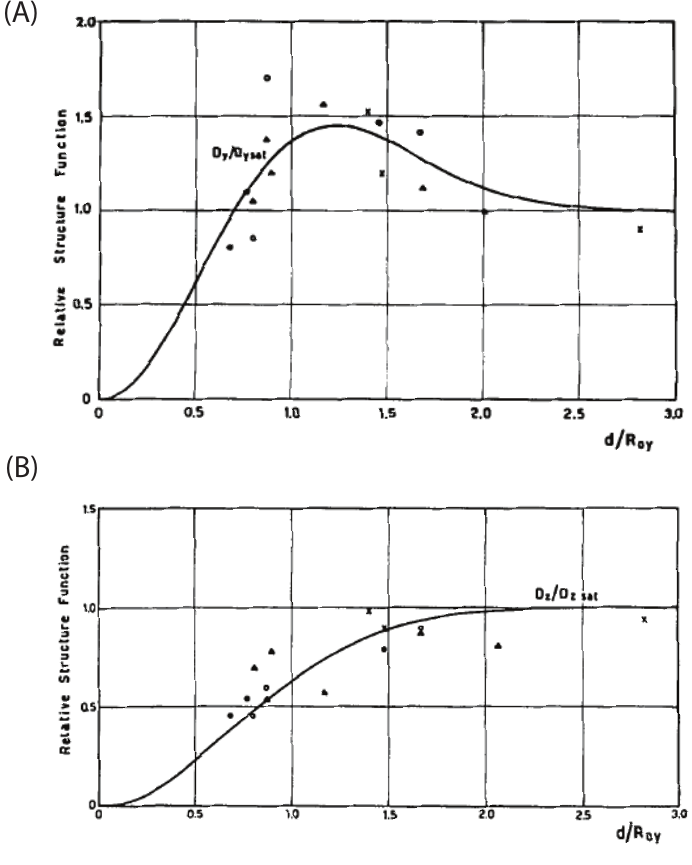
Figure 2. Measurement of anisotropic turbulence. Structure functions of the mean posi- tions of two beams: ( A ) horizontal D y ; ( B ) vertical D z , normalized by saturation values √ D j , sat = 4 π (cid:104) n (cid:105) 2 L 3 R ox /3 R oj , j = y , z , respectively. Here, (cid:104) n (cid:105) 2 is the root-mean square value of the refractive index fluctuations, L is the range, and R oj , j = x , y , z are constants on the order of outer scale. Reprinted with permission from Reference